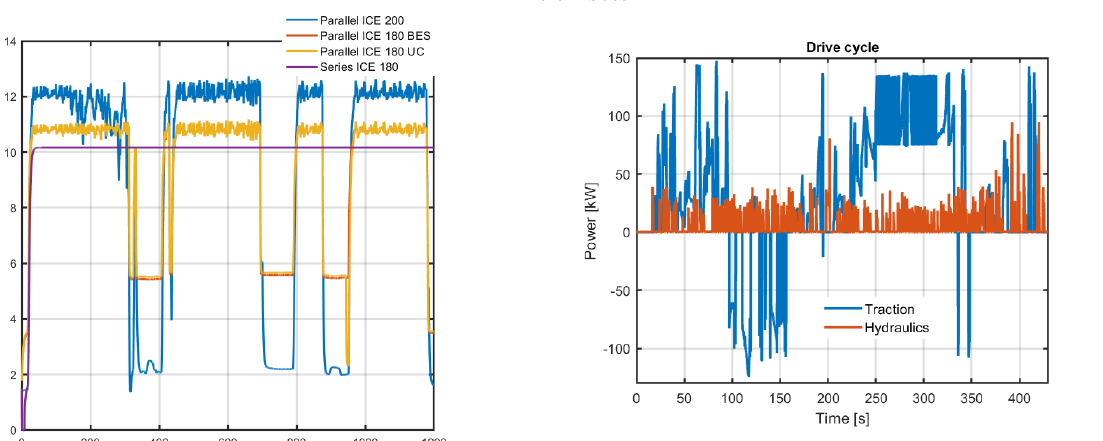
Figure 17: The load cycle of the underground